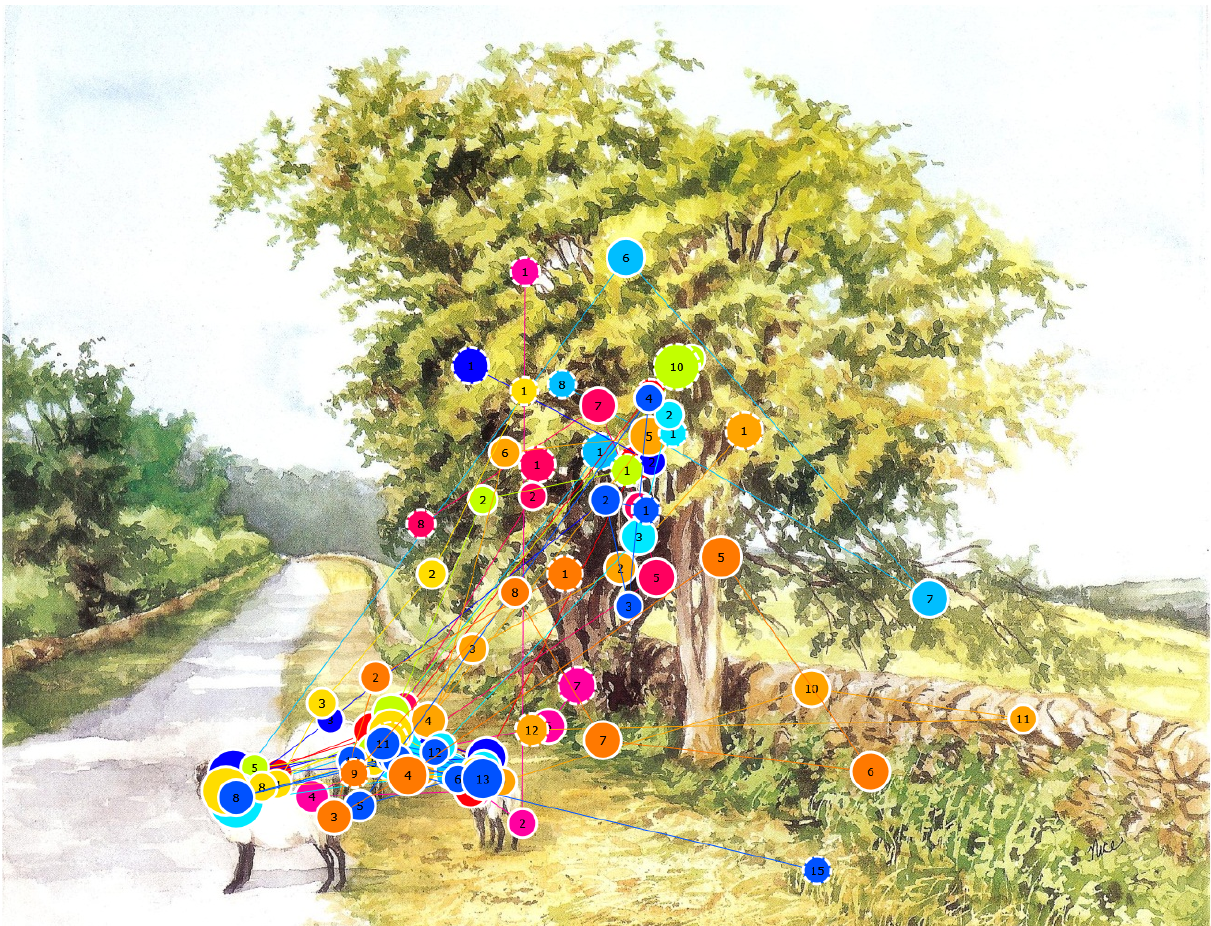
Figures 4a. Gaze plots over Painting 3, Sheep (Source: Nice,